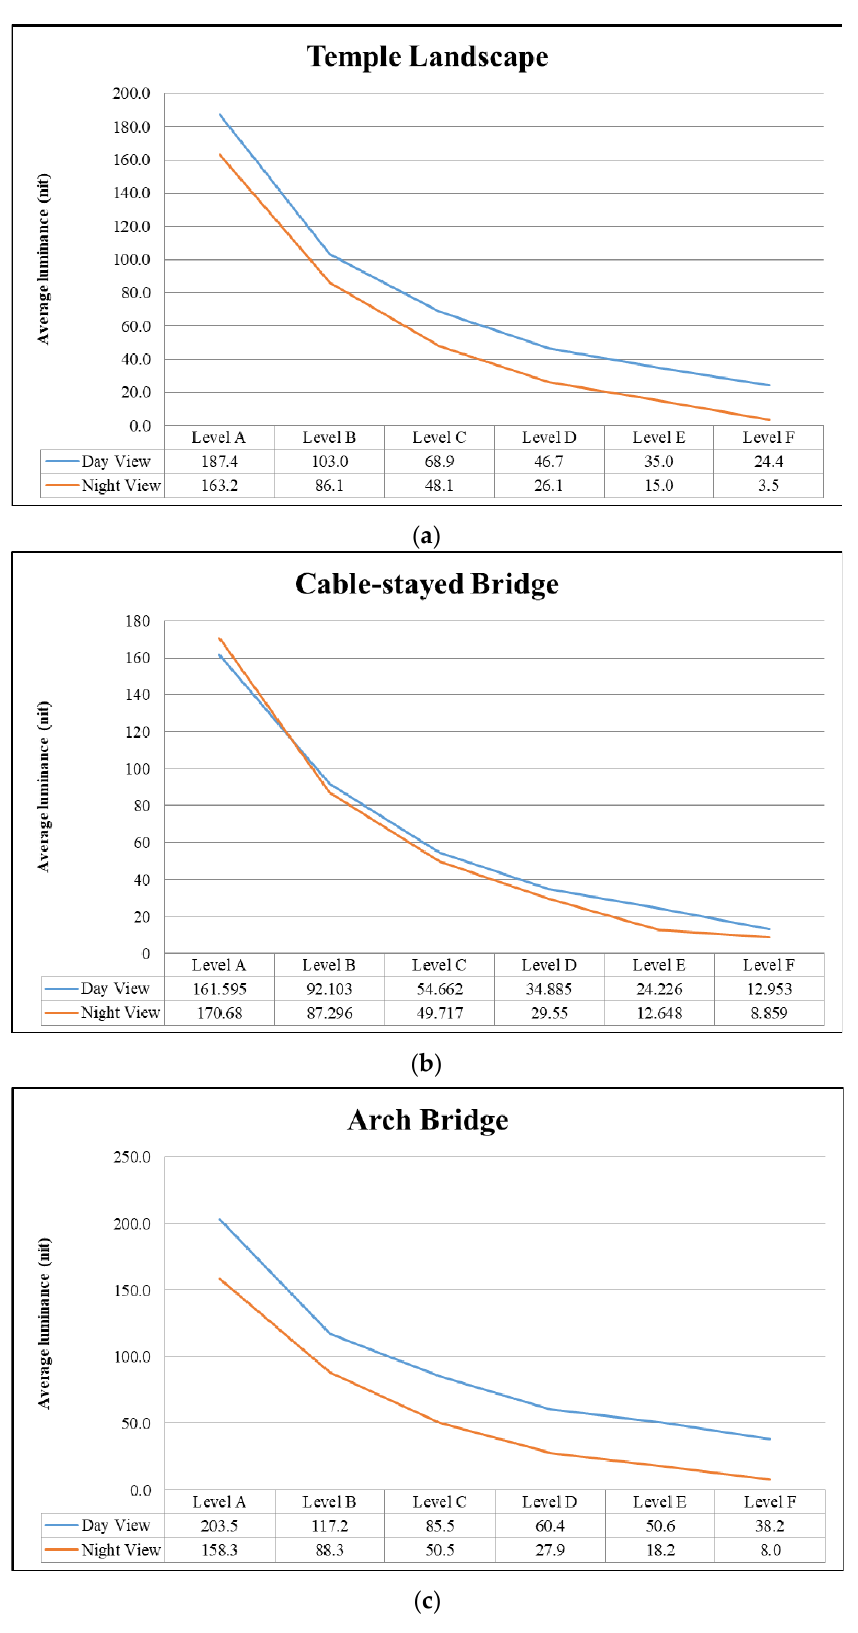
Figure 11. The average luminance of the : ( a ) temple landscape; ( b ) cable-stayed bridge; ( c ) arch